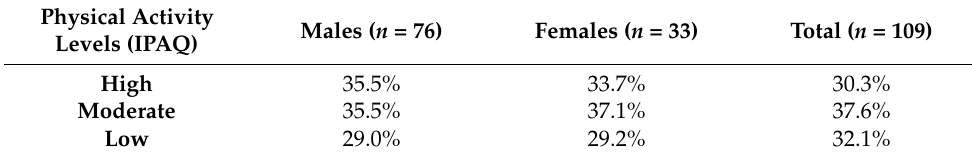
Table 2. Physical activity levels of the sample (IPAQ).